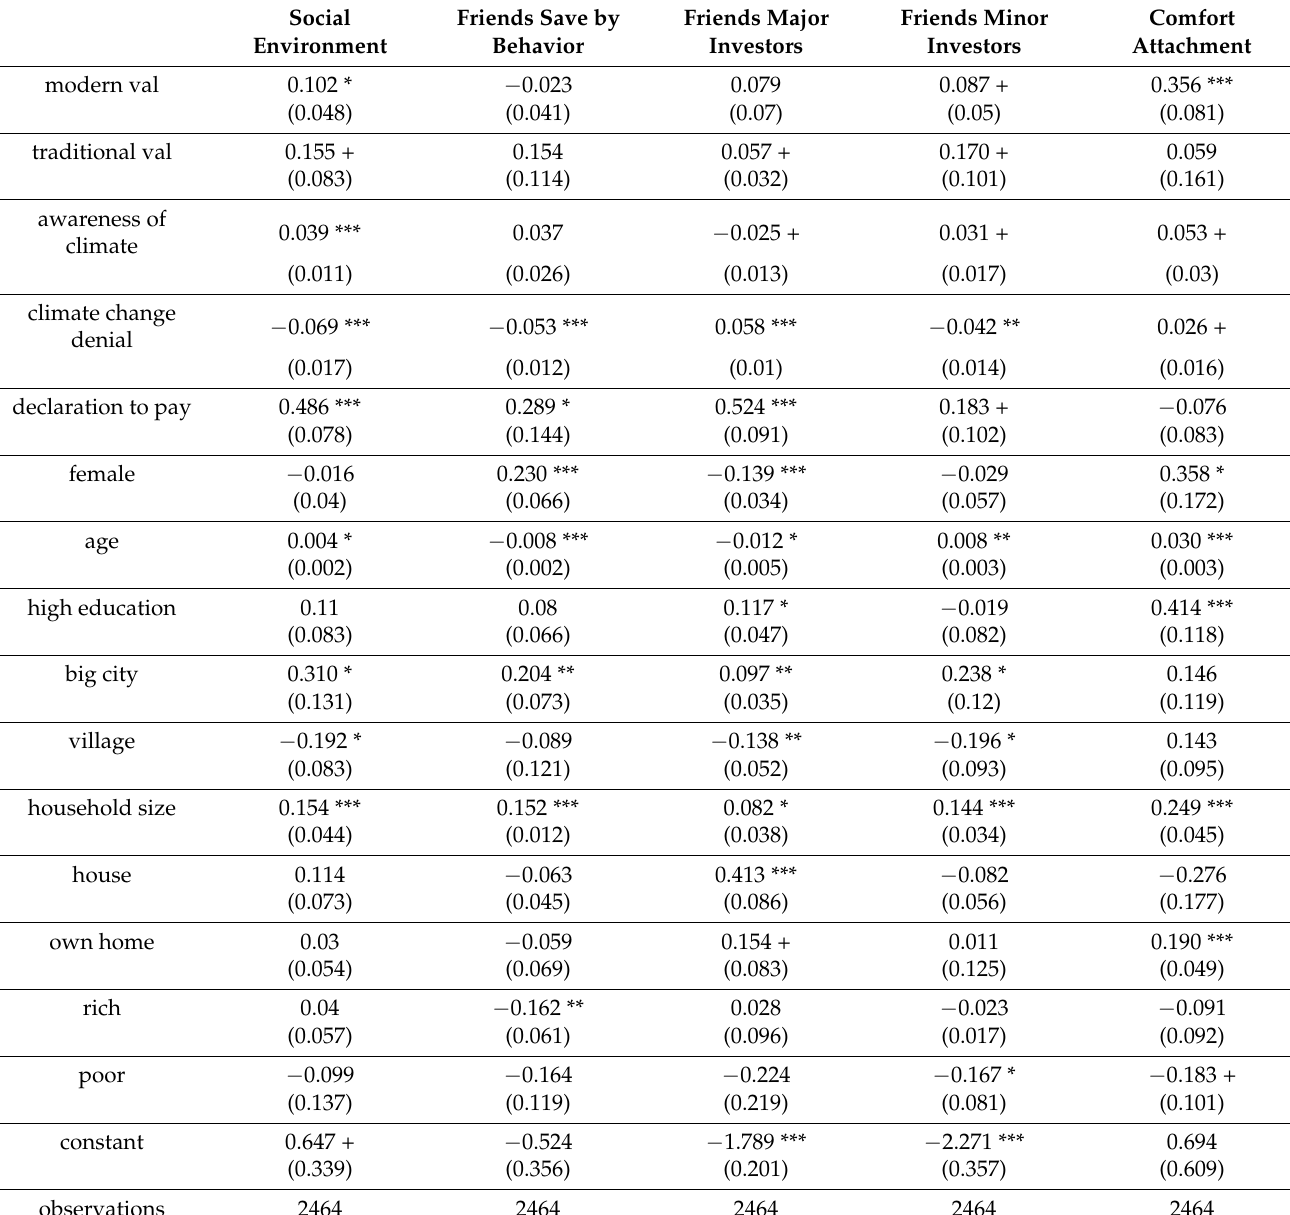
Table 3. Results from the GSEM, part III. Authors’ own analysis, based on data obtained during an online questionnaire completed in four countries. + p < 0.10, * p < 0.05, ** p < 0.01, *** p < 0.001, the standard errors clustered in countries are reported in